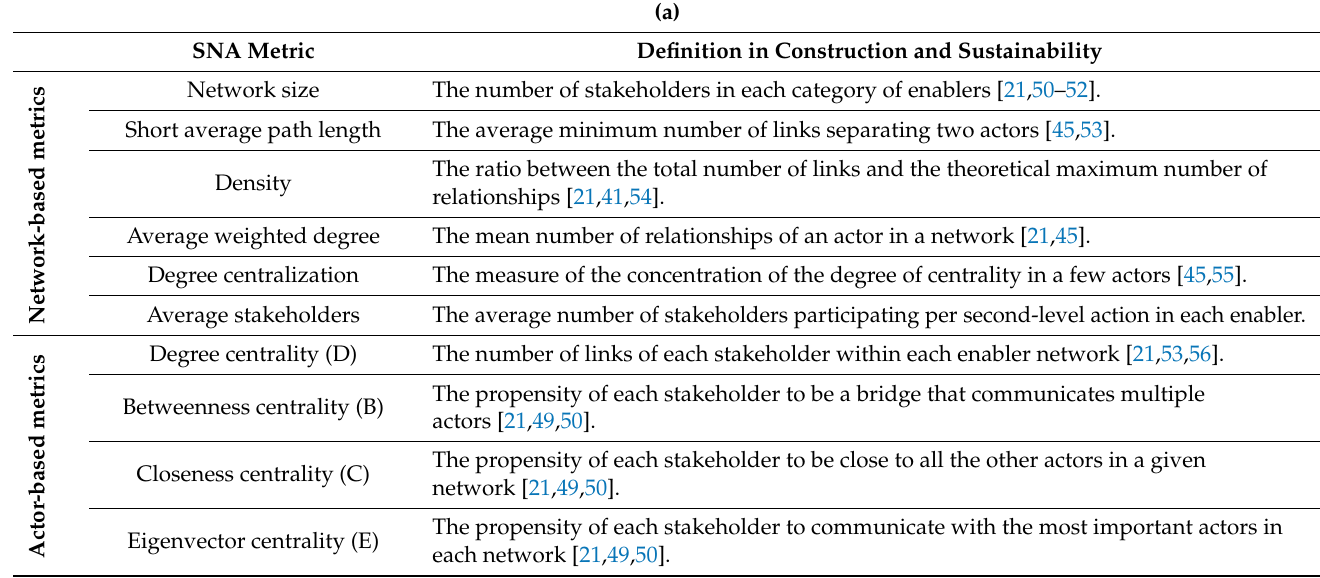
Table 5. Network-based metrics and Actor-based metrics.